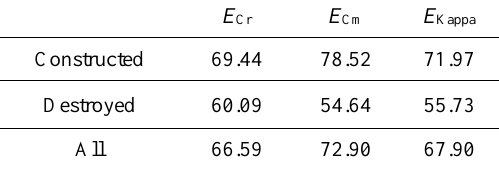
Table 2. The evaluation results of the change